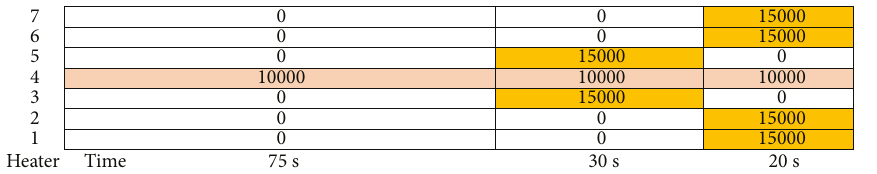
Figure 14: Altered heating